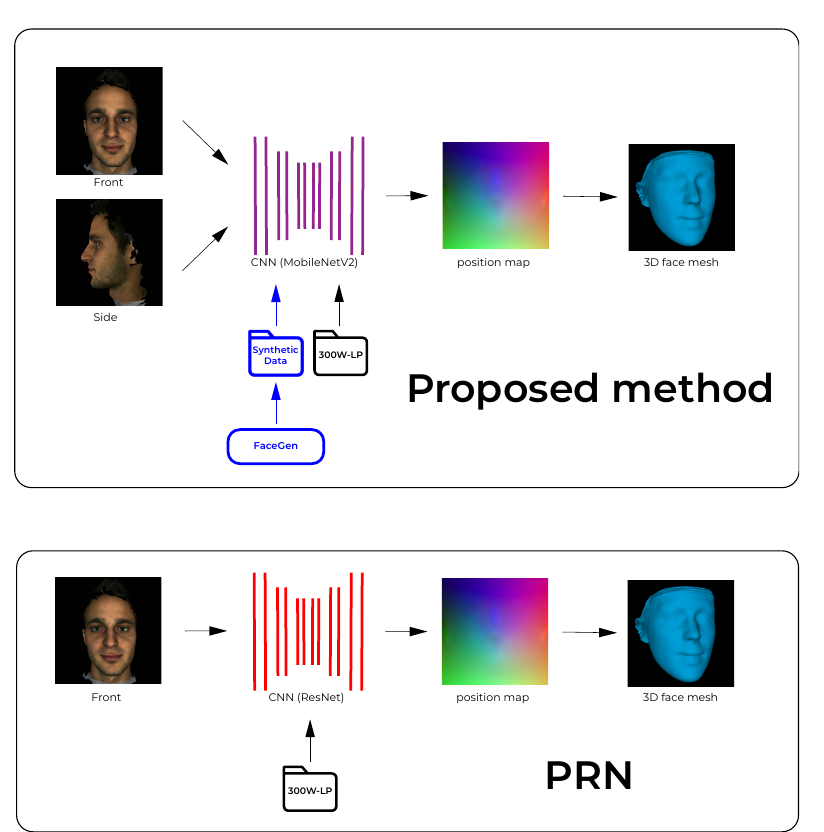
Figure 1. Outline of the proposed 2-input method for 3D face reconstruction ( top ), compared to the position map regression network (PRN) ( bottom ). The convolutional neural networks (CNN) in the proposed method was trained on both synthetic and real